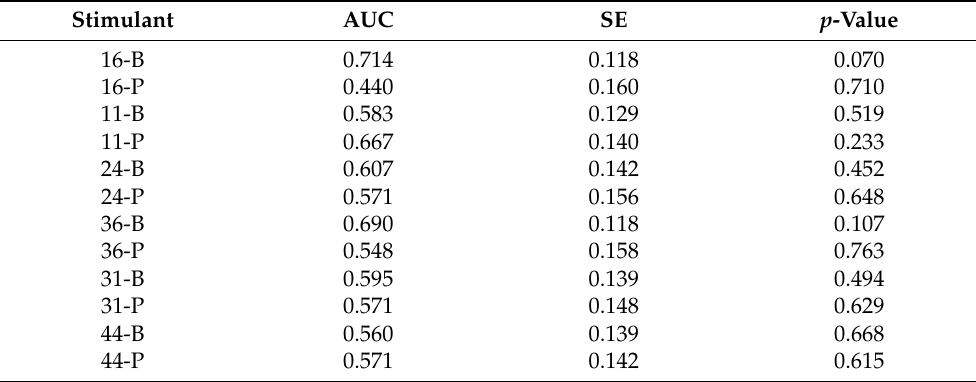
Table 5. Results of ROC analysis for interleukin-1 β